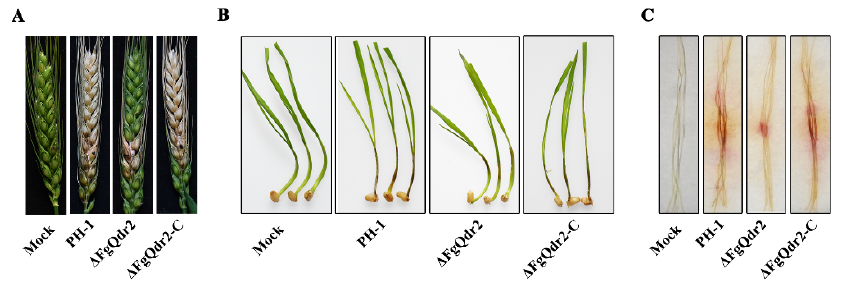
Figure 4. FgQdr2 is important for the virulence of F. graminearum . Virulence of each strain on wheat heads ( A ), coleoptiles ( B ), and corn silks ( C ). The mutant ΔFgQdr2 showed significantly reduced virulence on the above wheat tissues. The mock treatments indicate the corresponding host tissues inoculated with sterile water as a negative control.